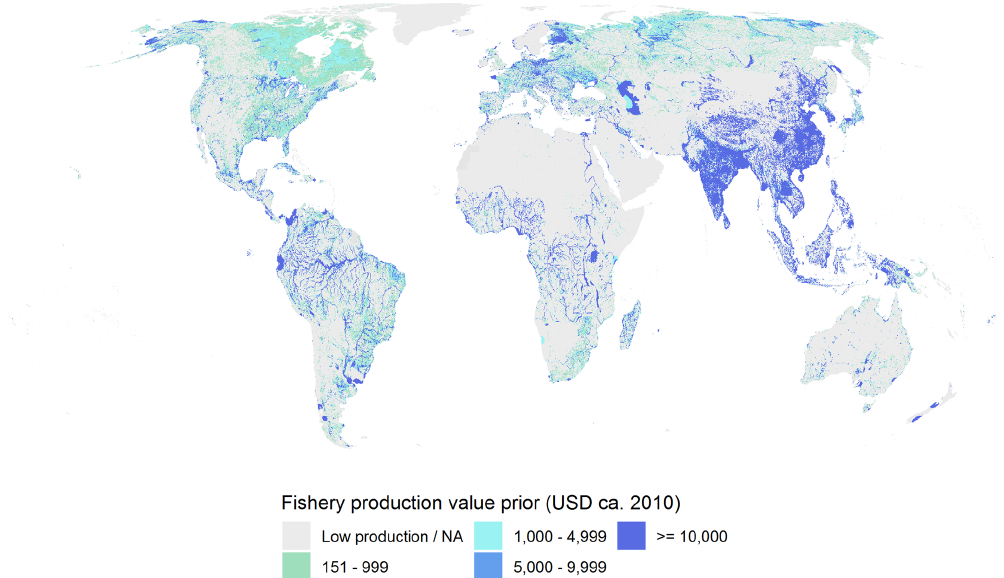
Figure 4. The assembled fishery production value used as a prior in the cross-entropy model (FAO, 2009; Lamarche et al., 2017; Hosch et al., 2019; National Geospatial-Intelligence Agency,